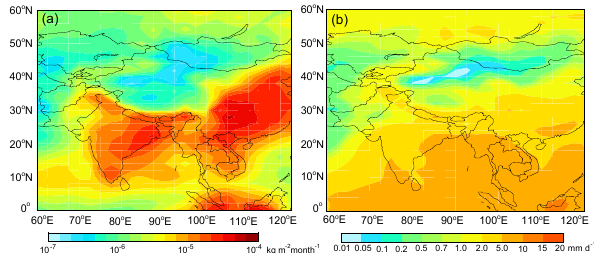
Figure 5. (a) GEOS-Chem simulated annual mean total BC depo- sition (kgm − 2 month − 1 ) over Asia and (b) GEOS-5 annual mean total precipitation (mmday − 1 ) over Asia. Values are for